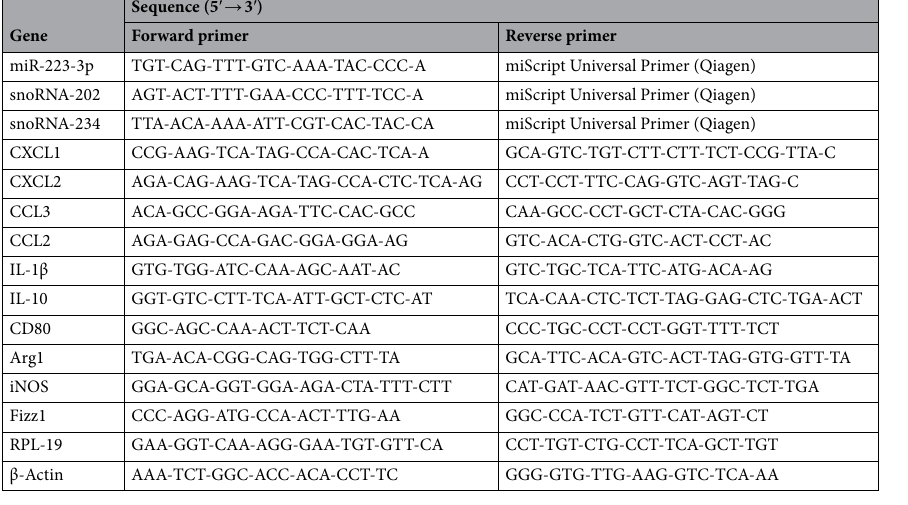
Table 1. Oligonucleotide primers used for miRNA and mRNA qRT-PCR